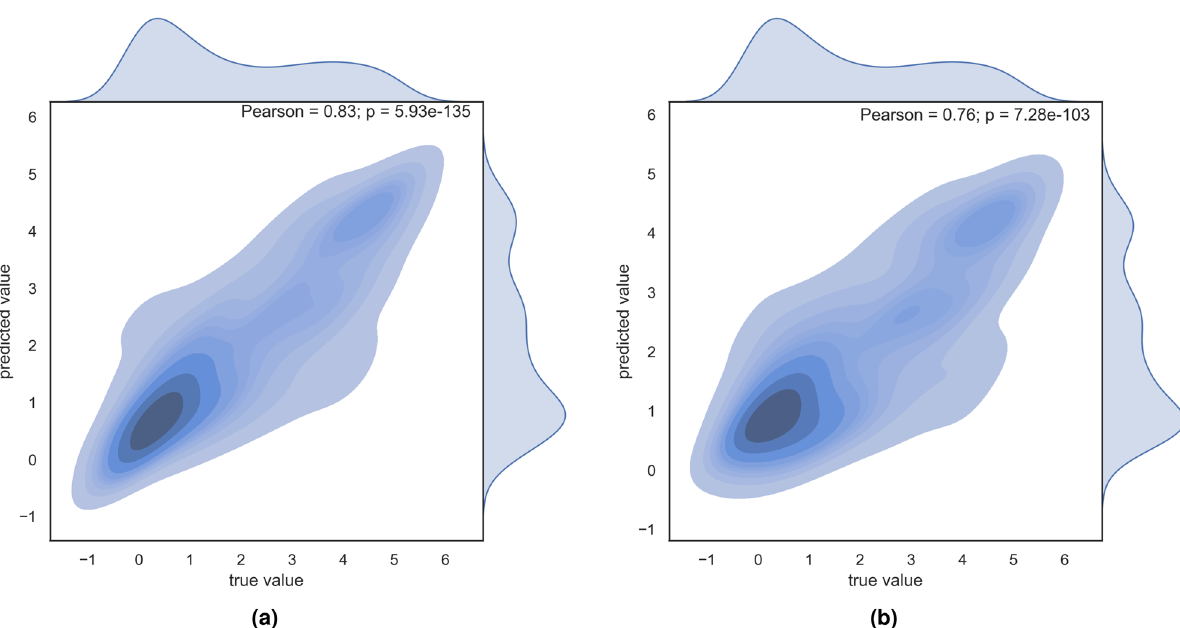
Figure 10. Joint plot of predicted and true values with marginal distributions ( a ) 10-fold, ( b )